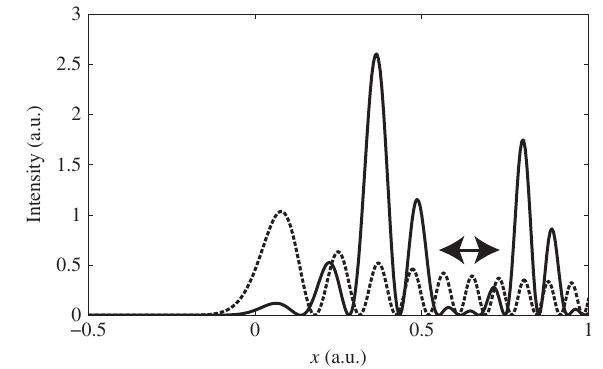
Figure 15: The intensity of a superoscillatory Airy beam (solid line) with a = 1.5, N = 5, compared to the intensity of a single Airy beam (dashed line) with the highest oscillation frequency of the